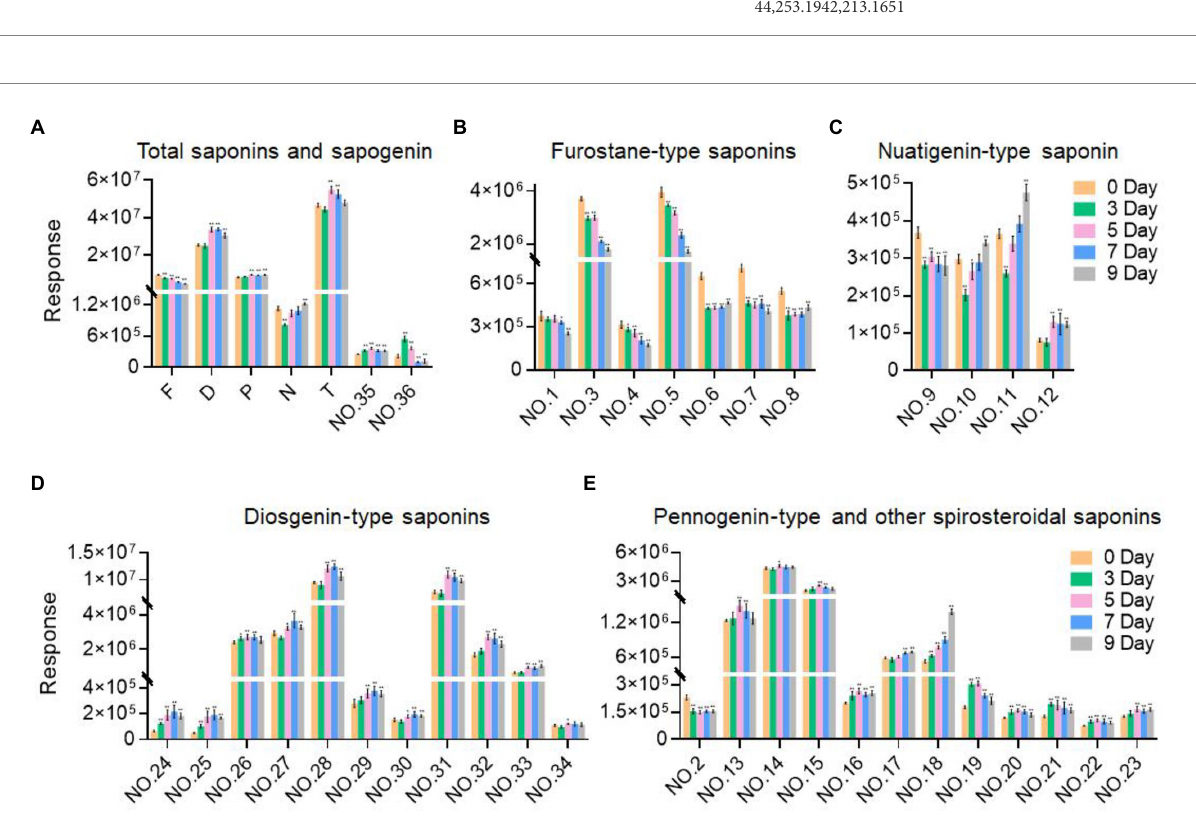
FIGURE 6 Variation trend of the response values of the selected components with the fermentation time. (A) Total saponins and sapogenin. (B) Furostane- type saponins. (C) Nuatigenin-type saponins. (D) Diosgenin-type saponins. (E) Pennogenin-type and other spiosteroidal saponins. Values are means ± SD. The asterisk above the bar chart denoted statistical significance (* p < 0.05, ** p < 0.01, and ns p >